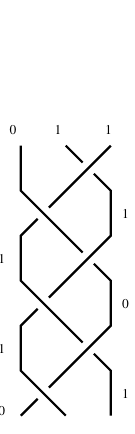
Fig. 4: Illustrative examples of non-trivial colorings of THK (3 , n ) ’s. A 2 -coloring of THK (3 , 3) with 2 colors and a 5 -coloring of THK (3 , 2) with 4 colors.